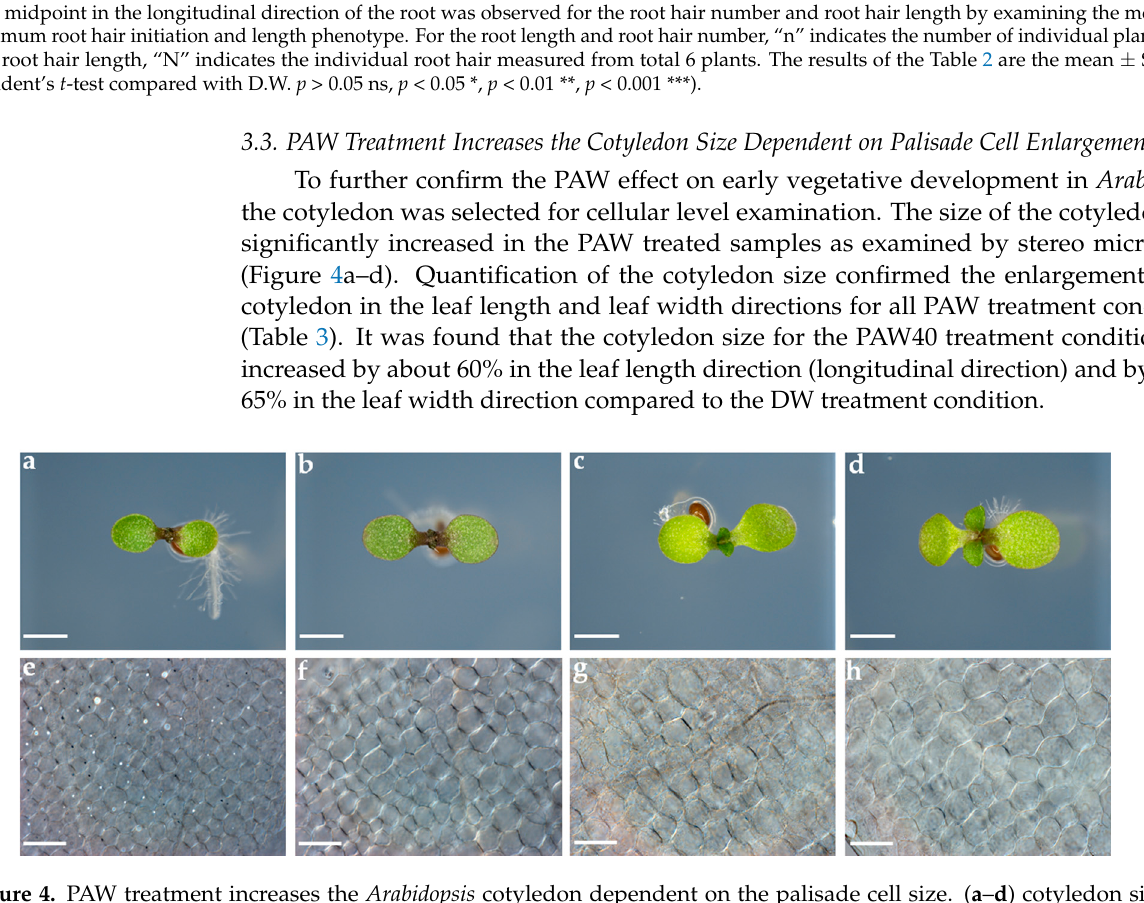
The midpoint in the longitudinal direction of the root was observed for the root hair number and root hair length by examining the most optimum root hair initiation and length phenotype. For the root length and root hair number, “n” indicates the number of individual plants. For root hair length, “N” indicates the individual root hair measured from total 6 plants. The results of the Table 2 are the mean ± SD (Student’s t -test compared with D.W. p > 0.05 ns, p < 0.05 *, p < 0.01 **, p < 0.001 ***).